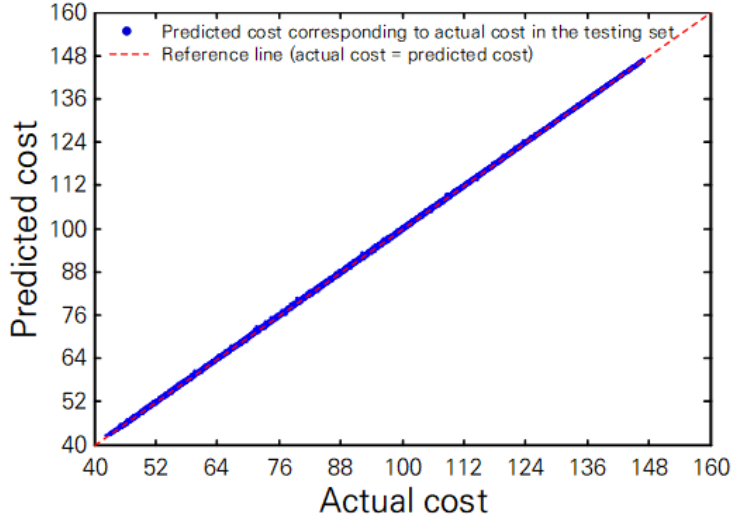
Figure 4. Testing set